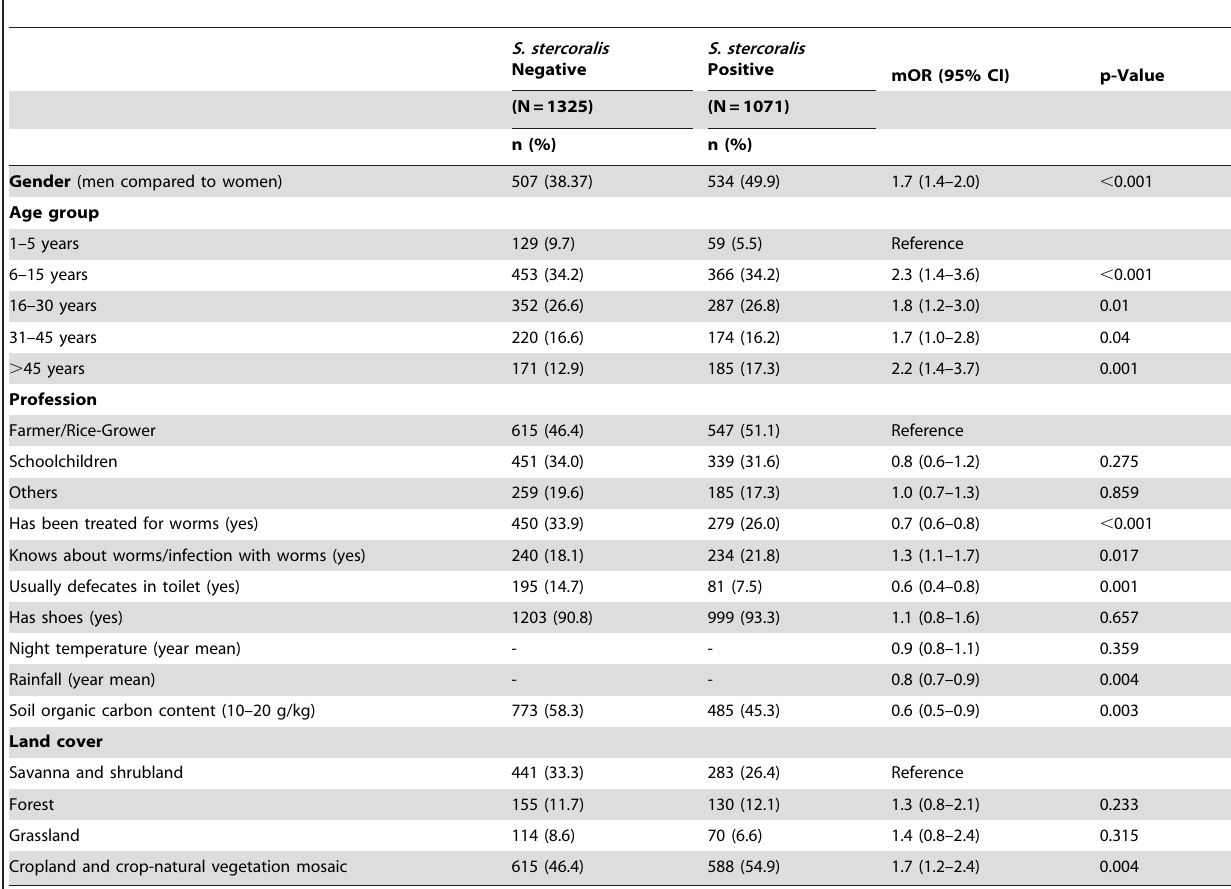
Table 2. Risk factors for S. stercoralis infection in the multivariate GEE among 2,396 participants, Preah Vihear province, Cambodia,